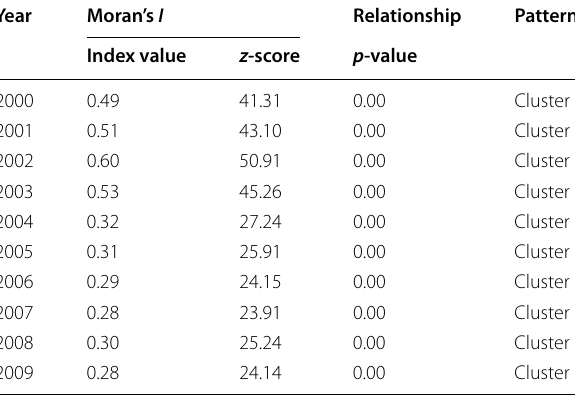
Table 2 Spatial patterns of PM Valley from 2000 to 2009 based on the Moran’s I